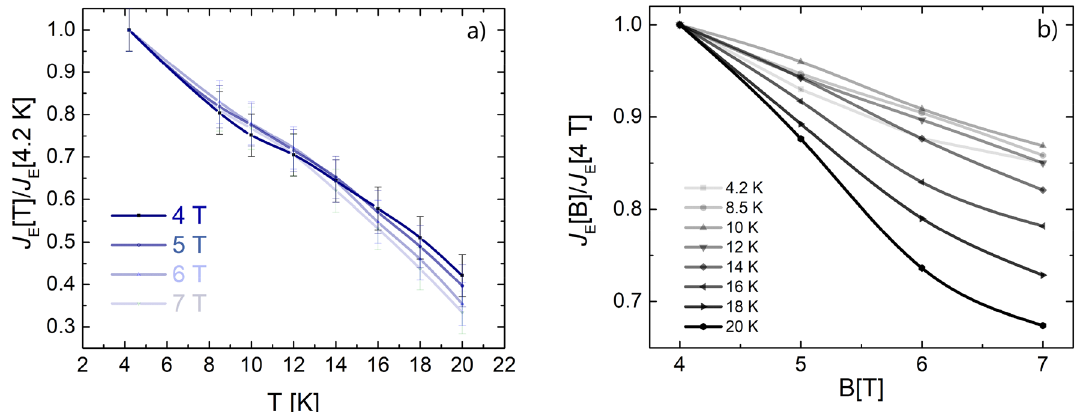
Figure 6. ( a ) Critical current density behaviour at different applied magnetic fields as a function of temperature; ( b ) critical current density behaviour at different temperature as a function of applied magnetic